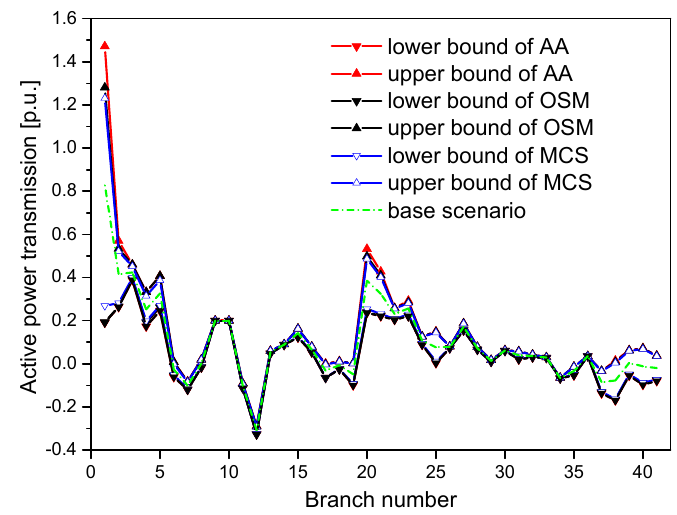
Figure 9. Ranges of active transmission power by three different methods. Energies 2018 , 11 , 3176